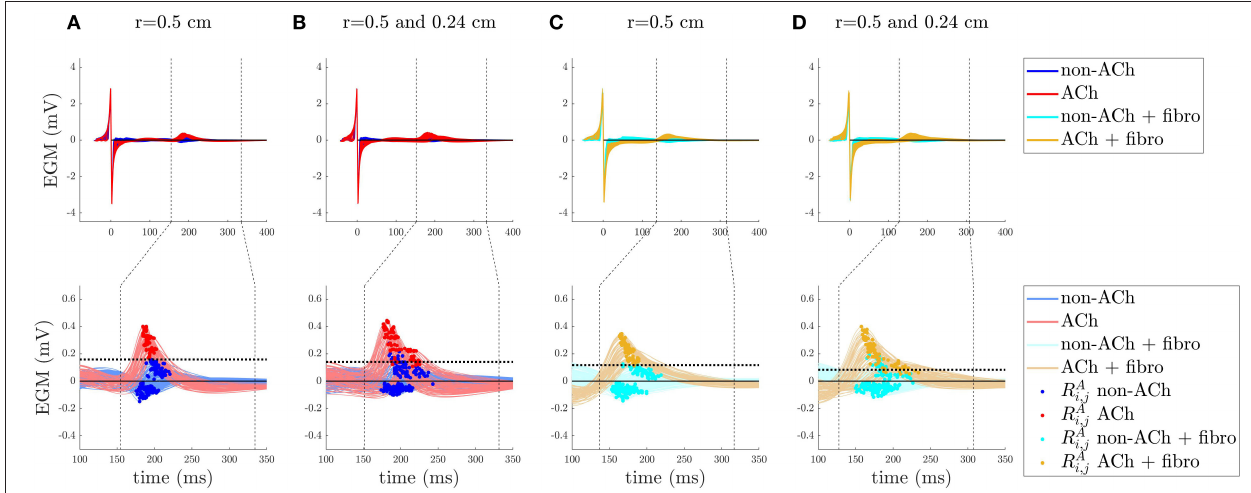
FIGURE 5 | EGM analysis for a non-AF tissue in (A,B) and a peroxysmal-AF (PxAF) tissue with 20% uniform diffuse fibrosis (Fu) in (C,D) . Top row: EGMs aligned with respect to the time correspondent to the maximum slope of the depolarization wave (marked as t = 0 in the x -axis). The vertical dashed lines delimit the time window TW for the R i , j ( t ) repolarization signals. Bottom row: atrial repolarization waves, R i , j ( t ), with dots indicating the maximum absolute value, R A i , j , of the waves within TW. The horizontal dotted lines represent the optimal threshold R th found by Se/Sp analysis.